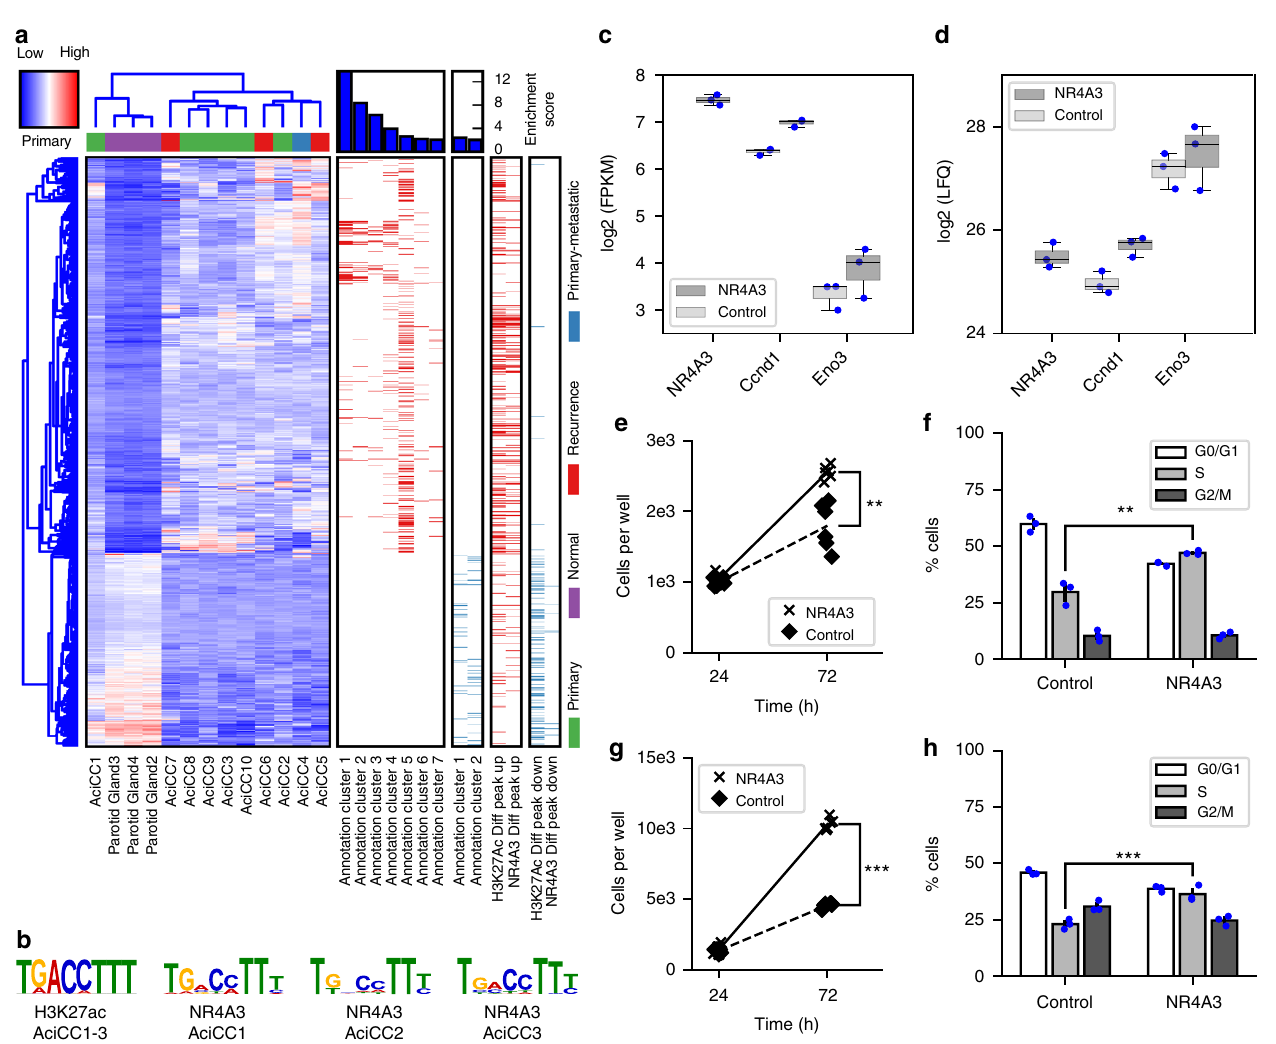
Fig. 6 Functional impact of NR4A3 upregulation in AciCCs. a Hierarchical clustering of ten AciCCs and three normal parotid gland samples based on signi fi cantly up- and downregulated genes (deSeq2 47 ; FDR = 0.01). Each row represents a gene, and each column represents a sample, with color-coding of gene expression levels. With the exception of one case, the tumors cluster separately from the normal tissues. Functional enrichment analysis reveals seven annotation clusters among upregulated genes, and two annotation clusters among downregulated genes. Genes associated with annotation clusters and differential H3K27ac and NR4A3 peaks are indicated by bars. Red and blue bars encode up- and downregulated genes associated with functional annotation clusters (left), and genes associated with up- and downregulated H3K27ac and NR4A3 peaks (right), respectively. b The NBRE motif is the only signi fi cantly enriched known motif at sites with upregulated H3K27ac peaks in the tumor samples (HOMER 54 ; P < 0.01). De-novo motif analysis of NR4A3 transcription factor ChIP-seq peaks in the tumor samples reveals the same NBRE motif in all three samples. c mRNA expression and d protein levels of NR4A3, Ccnd1, and Eno3 based on RNA sequencing and mass spectrometry analysis, respectively, in immortalized mouse submandibular gland cells transduced with NR4A3 or red fi re fl y luciferase (RedFF) negative control. Box-plots and individual values for three replicates are shown (Box-plot center line: median; bounds of box: 25 and 75 % quantiles; whiskers: minimum and maximum values). e , f immortalized mouse submandibular gland cells and g , h human mammary MCF10A cells with and without overexpression of NR4A3 open reading frames were seeded in microscopy plates and incubated for the indicated times. e , g Cell numbers were counted using high-content screening microscopy after staining with Hoechst-33258. Individual values of six replicates for each time point are presented. f , h For cell cycle analysis, cells were labeled with BrdU and 7-AAD and analyzed by FACS. Averages and standard deviations as well as individual values of three replicates are shown. Two-tailed Student ’ s t -test; ** P < 0.01, *** P < 0.001. Source data for Figs. 1a and 1c – h are provided as a Source Data fi